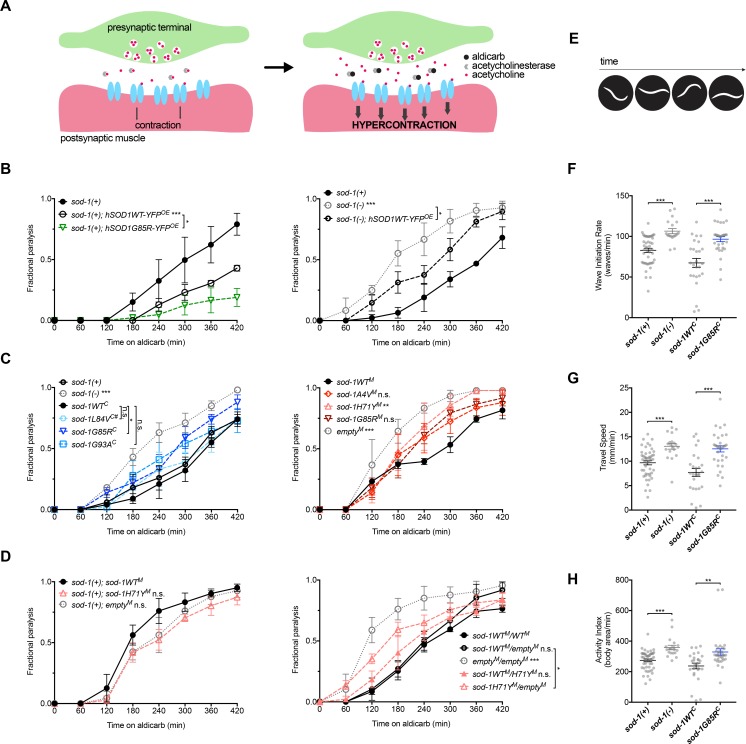
Neuromuscular junction activity differs in overexpression versus single-copy/knock-in models.(A) The drug aldicarb inhibits acetylcholinesterase and leads to acetylcholine build-up at the neuromuscular junction (NMJ) with a characteristic time course for paralysis in young adult animals. Either resistance or hypersensitivity to aldicarb indicates defective neuromuscular signaling. Increased NMJ activity can accelerate paralysis as acetylcholine accumulates more rapidly, while decreased NMJ activity can slow paralysis. (B) Left panel: Neuronal overexpression of human SOD1WT-YFP protein (hSOD1WT-YFPOE) results in aldicarb resistance, compared to non-transgenic wild type sod-1(+) control animals (standard N2 strain). Animals overexpressing human SOD1G85R-YFP (hSOD1G85R-YFPOE) were even more resistant to aldicarb than animals overexpressing human SOD1WT-YFP protein (hSOD1WT-YFPOE). Right panel: sod-1(-) animals were hypersensitive to aldicarb compared to wild type sod-1(+) controls. Neuronal overexpression of wild type human SOD1-YFP partially rescues aldicarb response in sod-1(-) animals. Fractional paralysis refers to the fraction of animals paralyzed at a given time point. Three independent trials in B-D. N > 30 for each genotype in all panels. Error bars indicate ±SEM. Log-rank test: * P < 0.05; ** P < 0.01; *** P < 0.001 in all panels. (C) Single-copy ALS sod-1 knock-in models and controls generated by MosSCI were tested in the sod-1(-) background for aldicarb resistance. sod-1H71YM animals, like sod-1 null emptyM controls, were hypersensitive to aldicarb compared to sod-1WTM wild type controls. While sod-1G85RM and sod-1A4VM models appear slightly hypersensitive, this difference was not significant. Single-copy ALS sod-1 knock-in models and their appropriate wild type controls generated by CRISPR/Cas9 were tested for aldicarb resistance. sod-1L84VC indicated with #. sod-1G85RC animals and sod-1(-) animals were hypersensitive to aldicarb, compared to sod-1WTC and sod-1(+) wild type controls (standard N2 strain), respectively. (D) Presence of the endogenous wild type sod-1(+) allele in sod-1H71YM animals and emptyM controls rescues aldicarb response, compared to sod-1WTM animals in the same background. Heterozygous sod-1WTM/H71YM animals had normal aldicarb response compared to homozygous sod-1WTM/WTM wild type controls. (E-H) Assessment of swimming in young adults animals after paraquat treatment was examined with computer vision software CeLeST [31]. Panel E illustrates body bends while swimming. sod-1G85RC and sod-1(-) animals had increased Wave Initiation Rate (Panel F), Travel Speed (Panel G) and Activity Index (Panel H) compared to their sod-1WTC and sod-1(+) controls, respectively. sod-1(+) wild type controls are the standard N2 strain. Two independent trials. N > 20 for each genotype. Error bars indicate ±SEM. Kruskal-Wallis test: * P < 0.05; ** P < 0.01; *** P < 0.001.